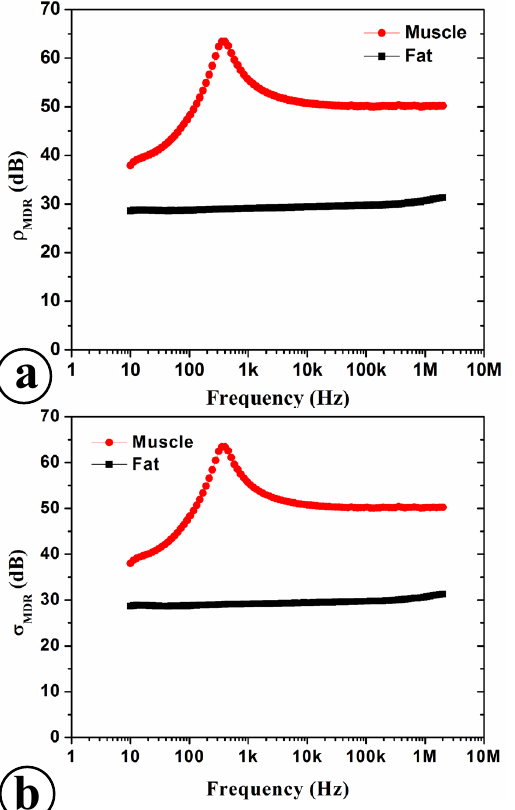
Figure-13: MDR of Z, θ , R and X of chicken muscle tissue paste and fat tissue: (a) Z, (b) θ, (c) R, (d) X.